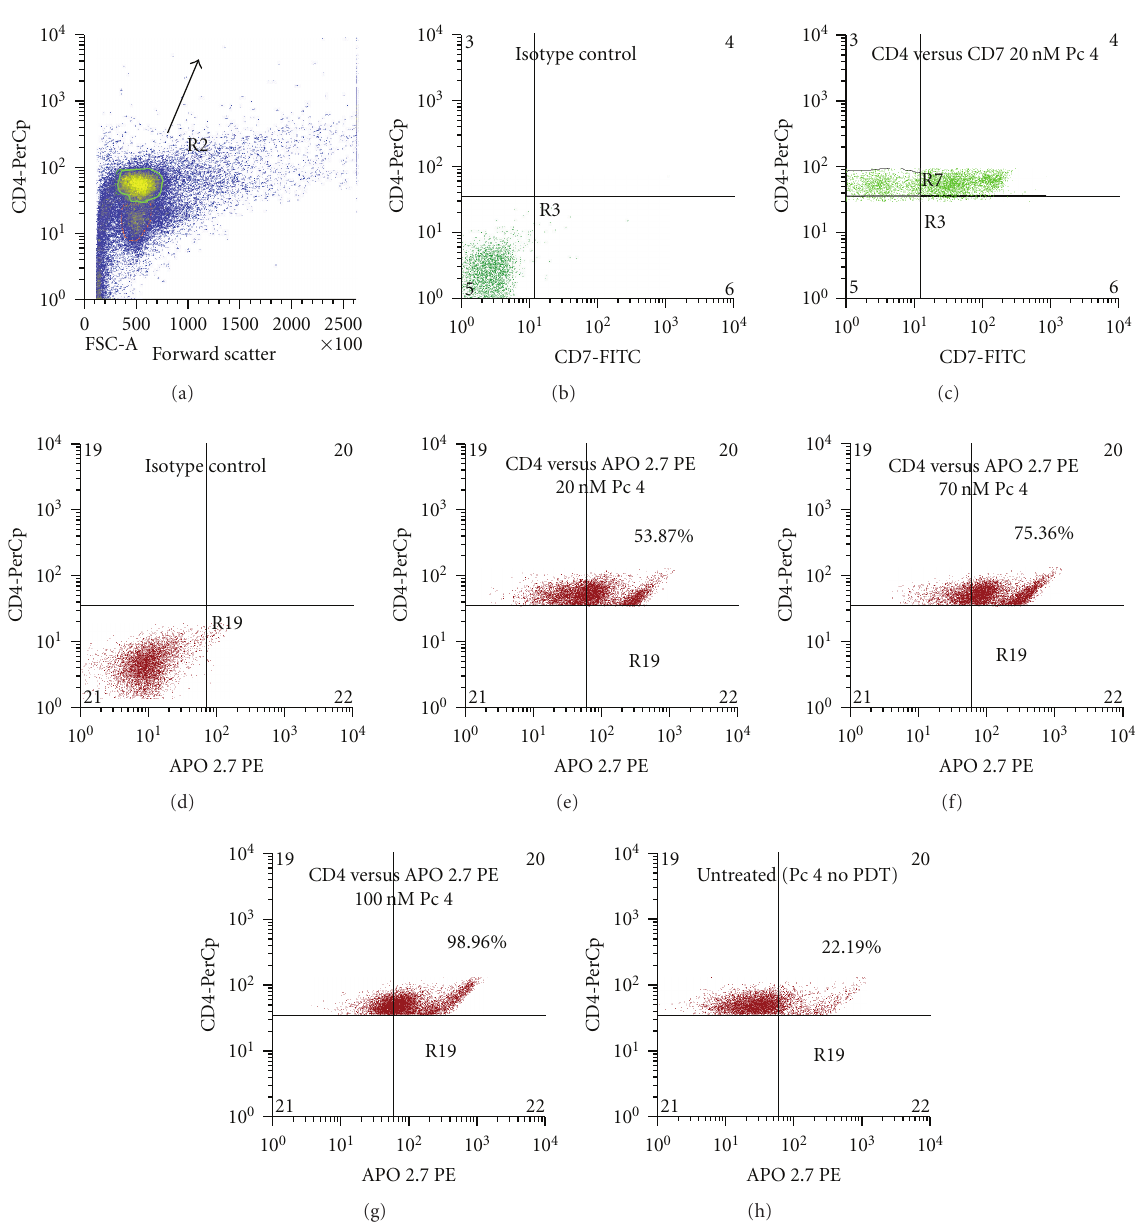
Cell viability was determined by trypan blue exclusion and was quantified using a